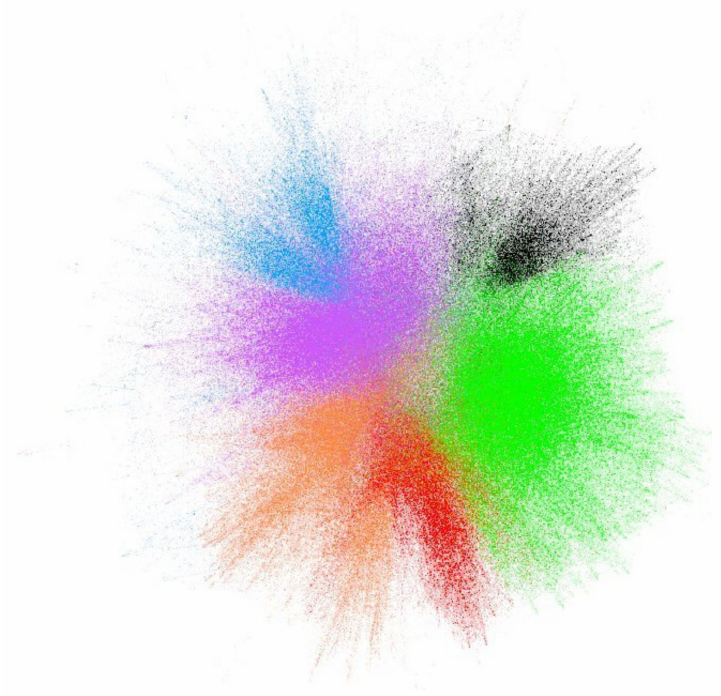
Figure 2. Representation of the communities that investigate EVs after debugging.